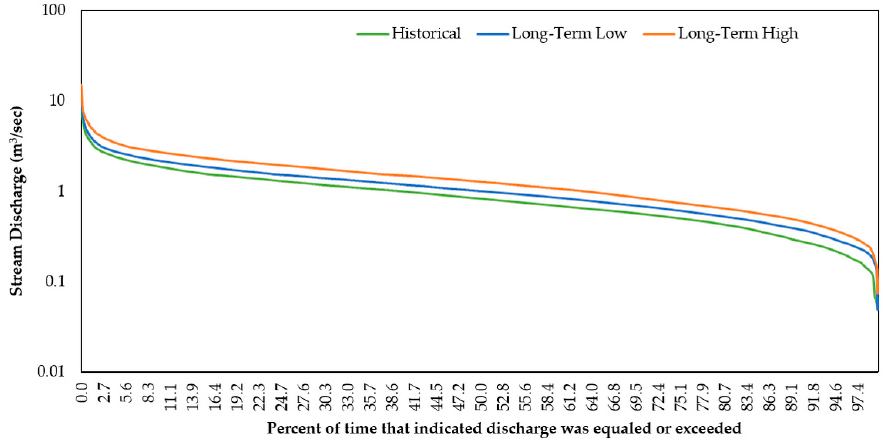
Figure 9. Queen River flow duration curves simulated for high and low CO 2 emission scenarios by